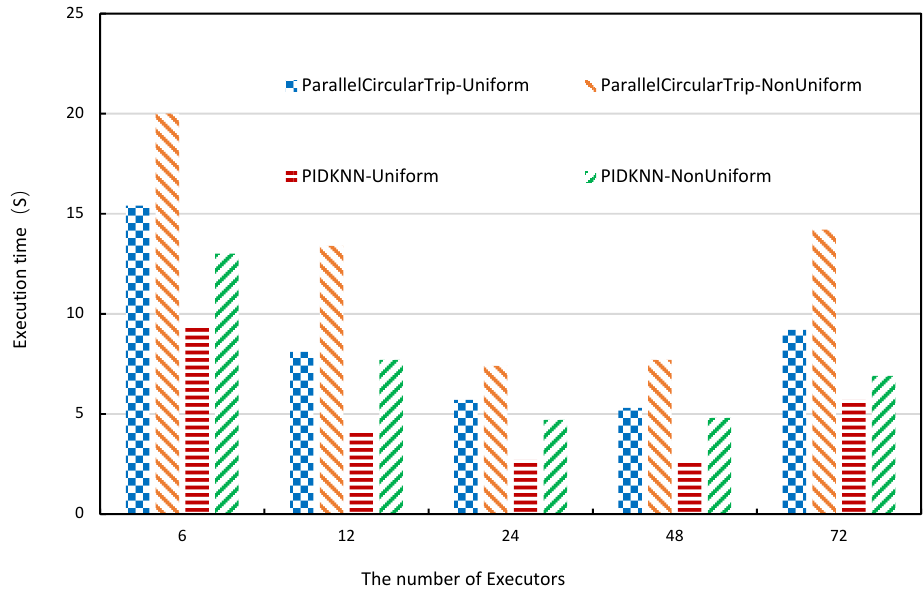
Figure 9. Execution time vs. the number of executors.